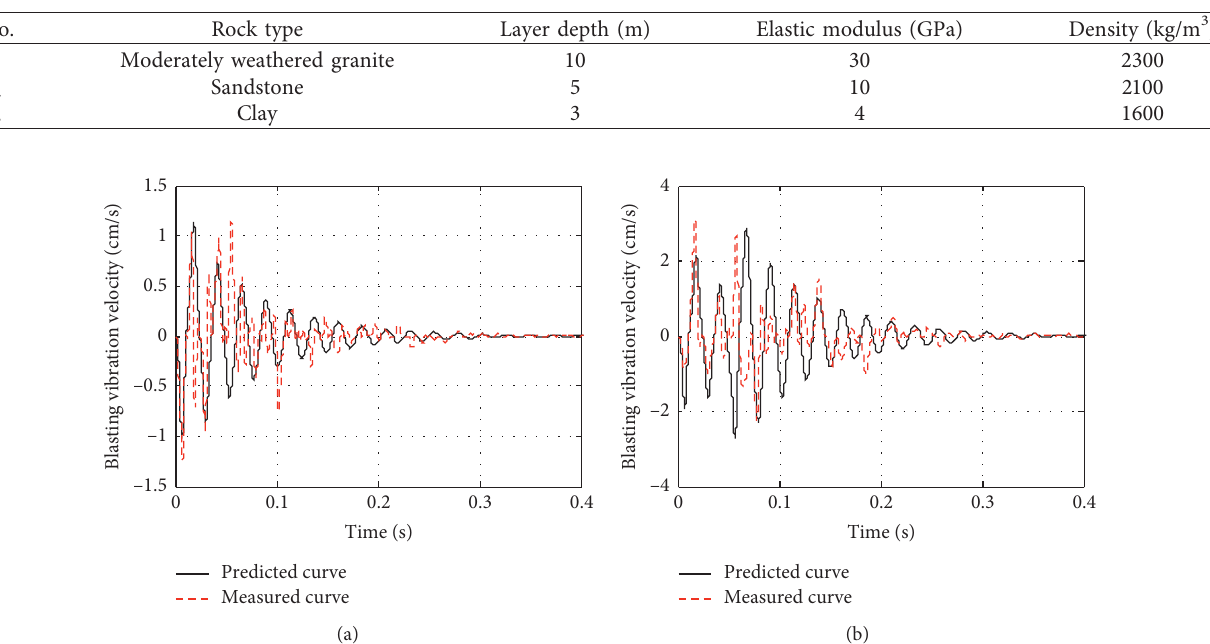
Figure 6: Layout of cut holes and distribution of rock layers. (a) Test 1. (b) Test 2. Table 2: Parameters of each rock layer in the upper part of